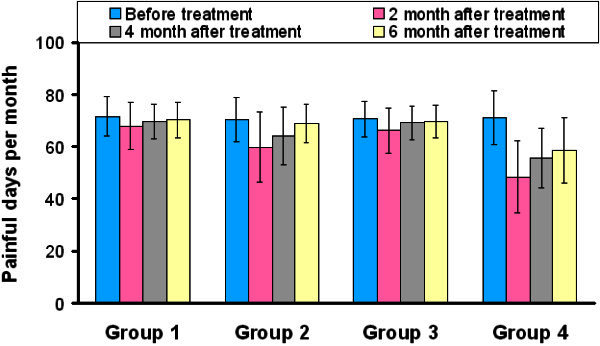
Graph showing the frequency of painful days before and after treatment in all groups.